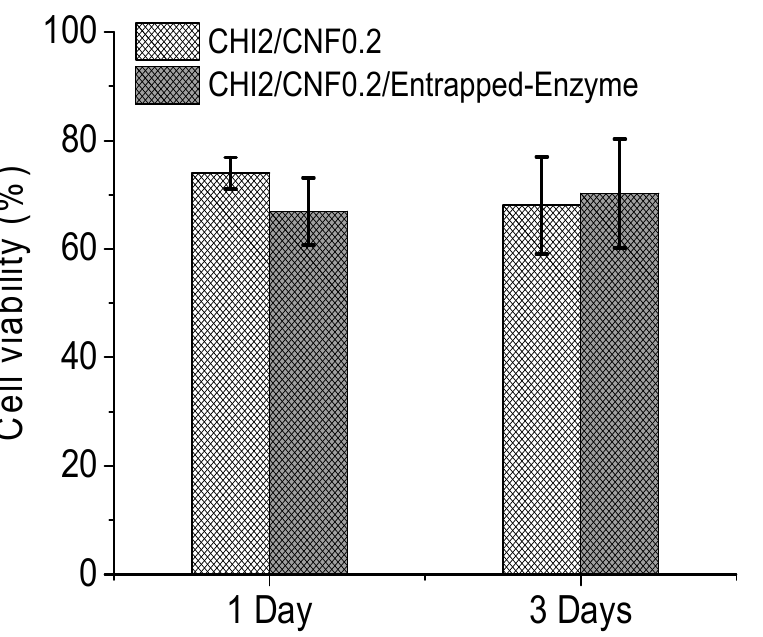
Figure 8. Cell viability at the different days for NIH 3T3 fibroblasts cultured on the 3D printed cellulase-laden cellulose nanofiber-filled chitosan hydrogels and on the printed CHI/CNF reference hydrogels containing no enzyme.